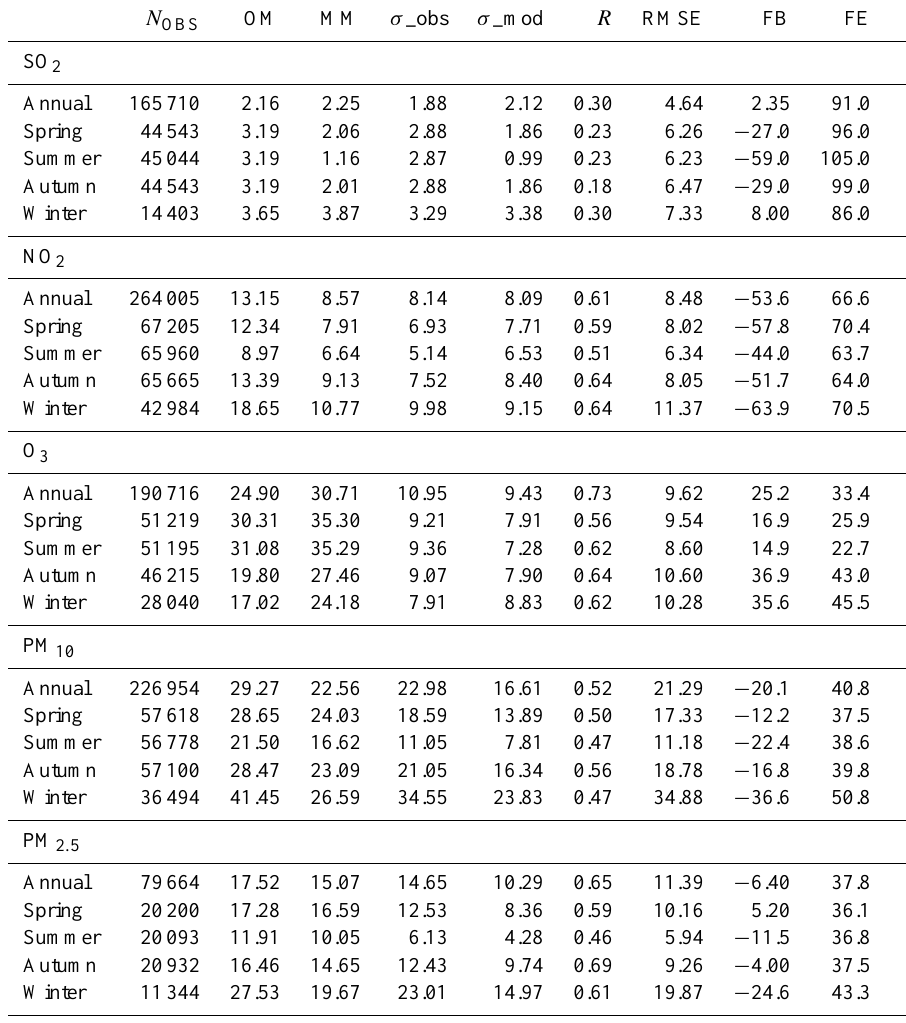
Table 5. Annual and seasonal scores calculated using the whole UB AirBase set of stations. The indicators and the associated units are identical to those in Table